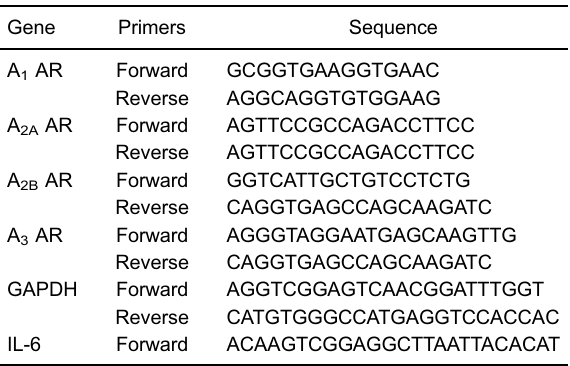
Table 1. List of primer sequences for reverse transcription-qPCR analyses.